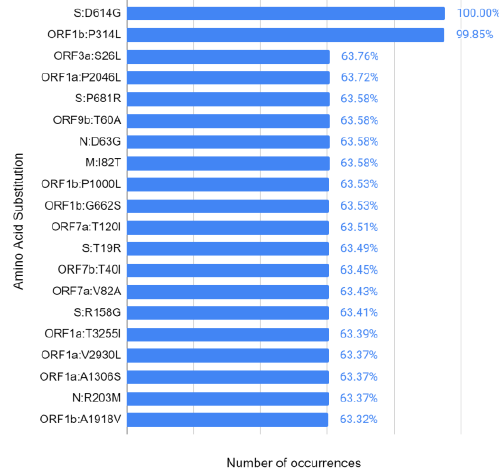
least one of them contributes to the increased transmissibility of SARS-CoV-2.